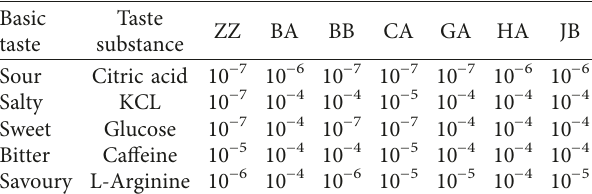
No. of parameters 9